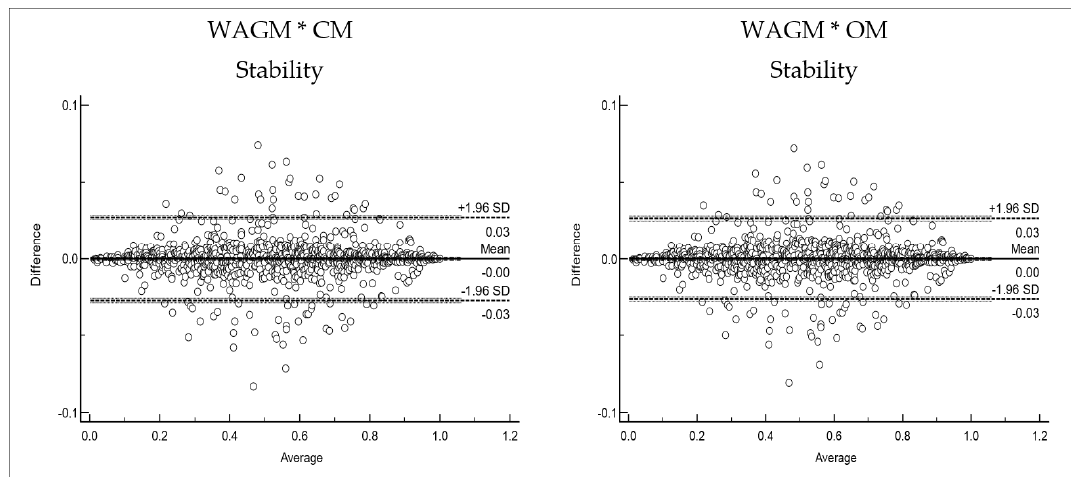
Table 1. Loading coefficients for each sub-scale of the three tested